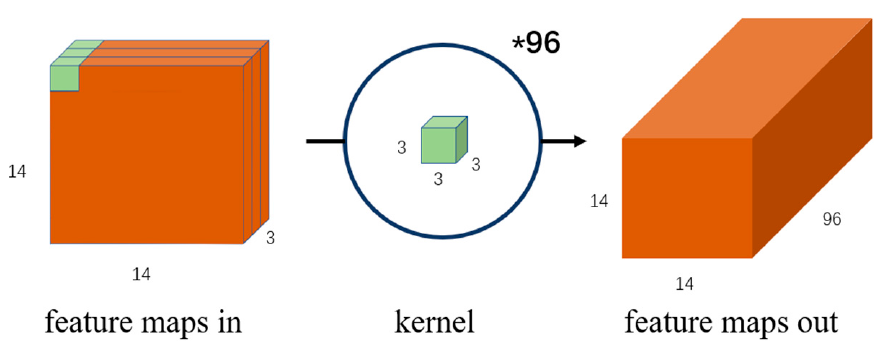
Figure 2. Standard convolution increases the dimension to 96.